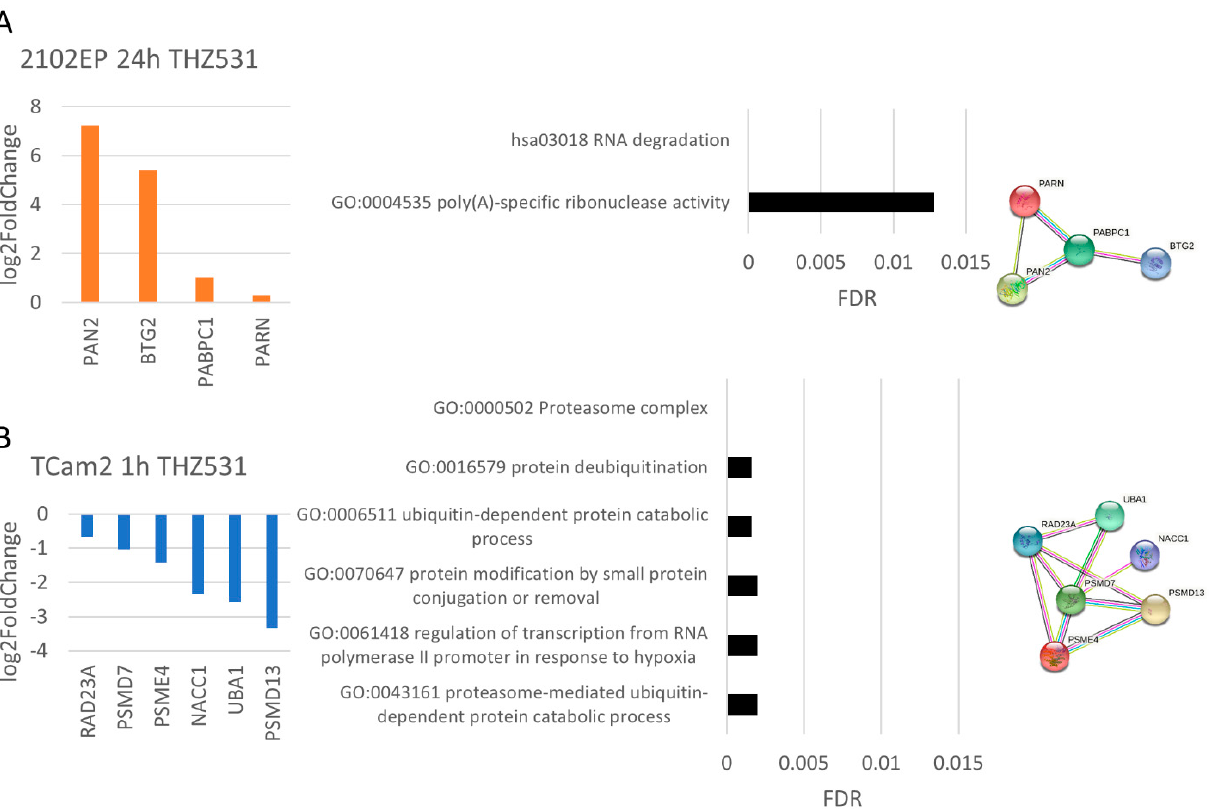
Figure 8. THZ531 treatment induced cell-line-specific responses. Differential gene expression data evaluated via Reactome pathway/Gene Ontology analysis and STRING interaction analysis are presented. Treatment of ( A ) 2102EP cells for 24 h and ( B ) TCam2 cell for 1 h (100 nM THZ531). For all samples, n =